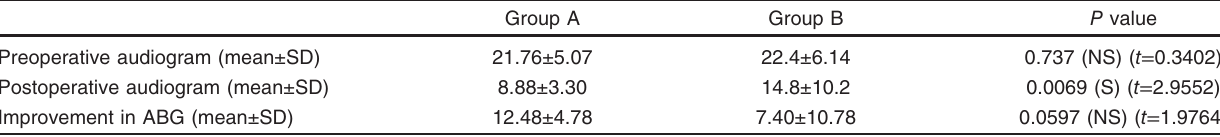
Table 2 Comparison between the studied groups as regards preoperative and postoperative audiogram